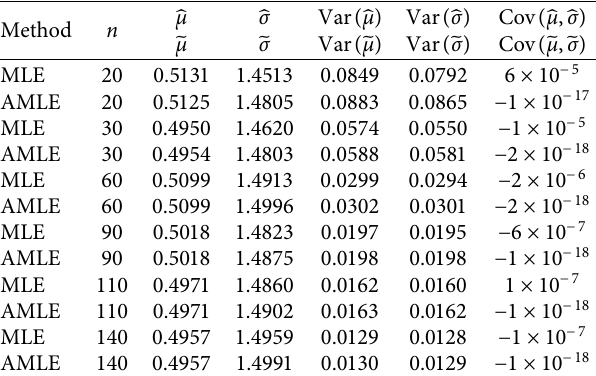
Table 1: Means, variances, and covariances of the MLEs and AMLEs of GG